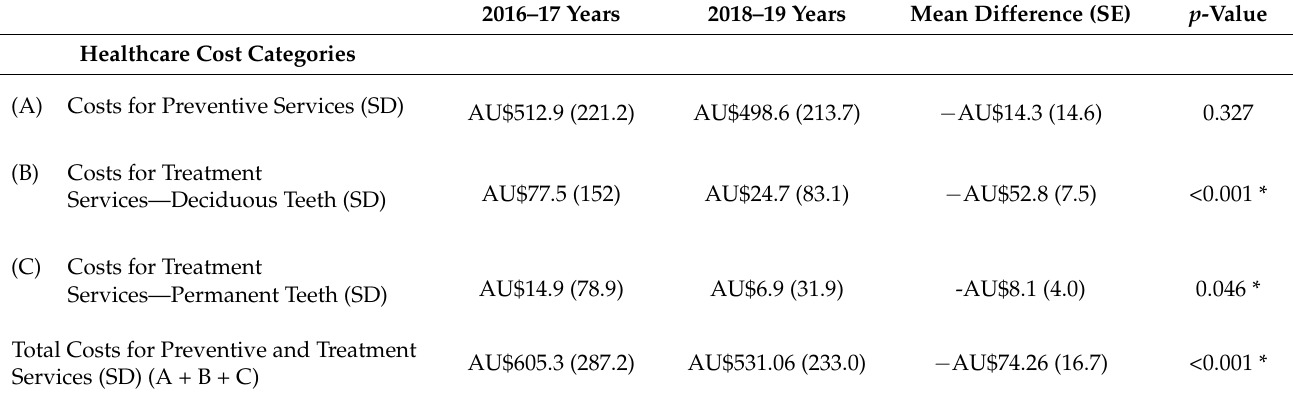
Table 2. Statistical analysis of the mean costs and dental treatment services utilised by children via the Teeth on Wheels dental